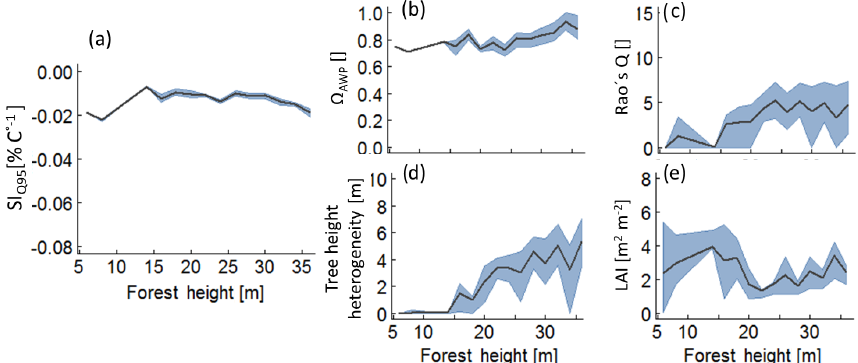
Figure B4. Analysis of those forests which lie above the 95% percentile of SI Q 95 , depending on forest height H forest . Lines indicate mean values of the subsamples and the grey bands indicate the interquartile range. Panel (a) shows the temperature sensitivity of productivity to forest height, analysing only values above the 95% percentile; (b) to (e) show the change of the remaining forest properties within the subsamples.